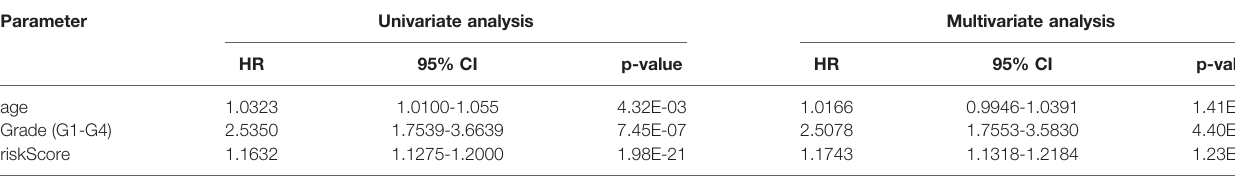
TABLE 3 | Univariate and multivariate analysis of the correlation of 13 gene expression values with OS among the patients. Parameter